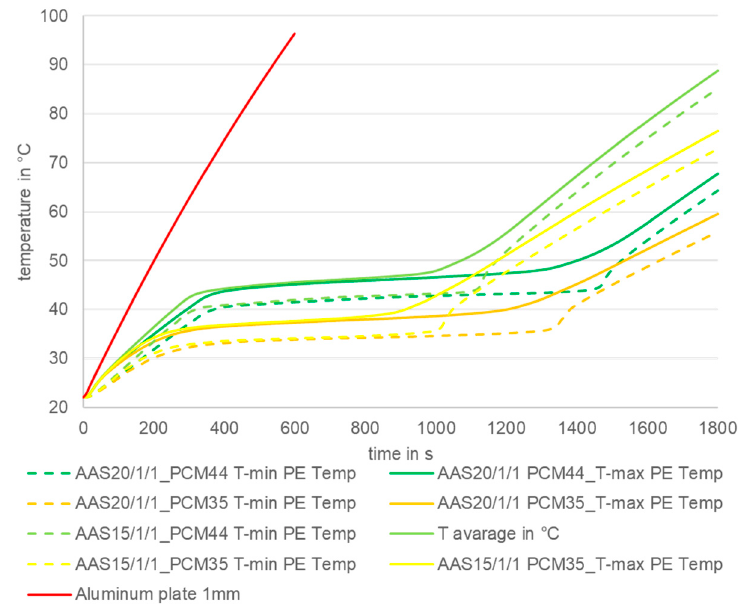
Figure 4. Simulated temperature curves of aluminum foam sandwiches (AAS) infiltrated with PCM and aluminum plate for the defined thermal PE load case .